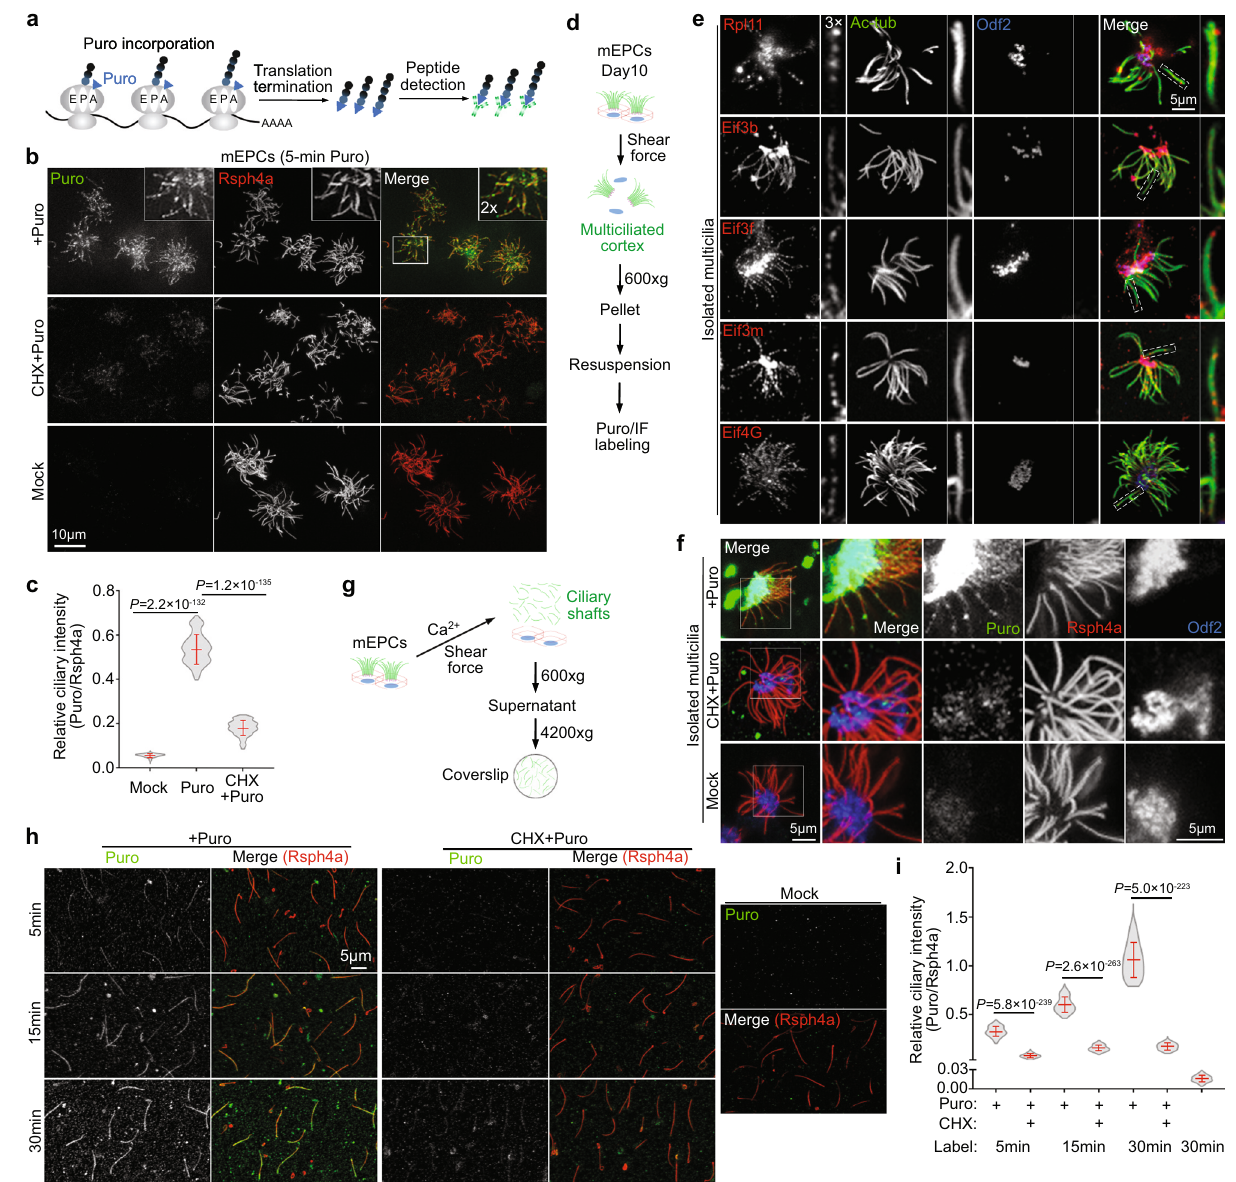
Fig. 3 Ependymal cilia display local protein synthesis. Relative intensities of ciliary Puro were from three independent experiments. The bars and errors represent mean ± s.d. Two-tailed student ’ s t -test. a Diagram illustrating metabolic labeling of nascent peptides with Puromycin (Puro). Puromycylated peptides were visualized with an anti-Puromycin antibody. The E-, P-, and A-sites in the ribosome are depicted. b, c Protein translation-dependent Puro IF signals were readily detected in multicilia. Day-10 mEPCs were pulse-labeled with Puro for 5 min with or without Cycloheximide (CHX) and then processed for confocal imaging ( b ). Rsph4a, a radial spoke subunit, served as multiciliary marker 71 . The framed region was magni fi ed to show details. In c , 150 multiciliated mEPCs were quanti fi ed in each condition. Ciliary intensity of Puro was normalized to that of Rsph4a. d Diagram illustrating the isolation of multicilia-containing apical cortexes. e Multicilia of the isolated cortexes retained translation machinery components and basal bodies. Ac-tub and Odf2 served as ciliary and basal body markers, respectively. f Protein translation-dependent Puro IF signals were detected in isolated multicilia. Pulse labeling was performed as in b . g Diagram illustrating the isolation of ciliary shafts. Multiciliated mEPCs were cultured to day 10 in fl asks. After the culture medium was replaced with Ca 2 + -containing deciliation buffer 23 , the fl asks were shaken horizontally to release individual ciliary shafts. The ciliary shafts in the supernatant were then spun onto poly-L-lysine-coated coverslips for further analyses. h, i Isolated ciliary shafts displayed local protein translation. Isolated ciliary shafts attached to poly-L-lysine-coated coverslips were pulse-labeled with Puro for 5, 15, and 30 min with or without CHX. Mock-treated samples served as negative control. After fi xation, the samples were immunostained for Rsph4a and subjected to confocal imaging ( h ). In i , 300 cilia were quanti fi ed in each condition. For each ciliary shaft, the total ciliary IF intensity of Puro was normalized to that of tracheal epithelial cells (mTECs) 40 and found that they contained protein 1), and RNA helicase Upf1, are involved in local mRNA mRNA hybridization signals of only 10 candidate RBP genes, localization 21,41 , whereas the remaining three, Pspc1, Nucleolin, and U1-70K, are nuclear RBPs located in paraspeckles, nucleoli, among which 6 candidate genes displayed upregulation and and spliceosomes, respectively 42 – 44 . As Fmrp is the best docu- persistent expression during the multiciliation (Fig. 4b). Inter- mented mRNP component critical for mRNA delivery into estingly, three of them, Fmrp, Caprin1 (cell cycle-associated